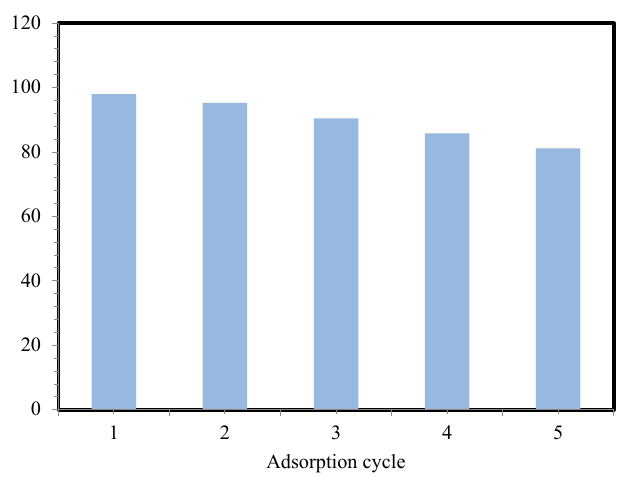
O /RGO adsorption of 3 4